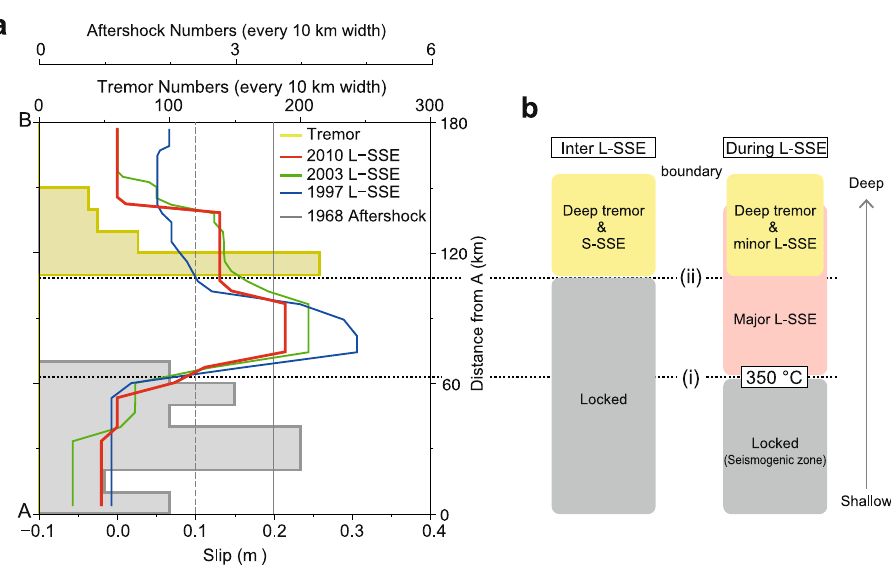
Figure 4. ( a ) Blue, green, and red lines represent slip distributions of the 1997, 2003, and 2010 L-SSEs along line AB (as in Fig. 2b). Yellow line shows the total tremor numbers in 10-km increments along line AB. Grey line shows the total number of aftershocks for the 1968 Hyuga-nada earthquake (in Figs 1 and 3) in 10-km increments along line AB. ( b ) Schematic of the spatial distribution of the locked zone, L-SSE, S-SSE, and deep tremors. The graph is created by Generic Mapping Tools software (GMT v4.5.12; http://gmt.soest.hawaii. edu/) 33